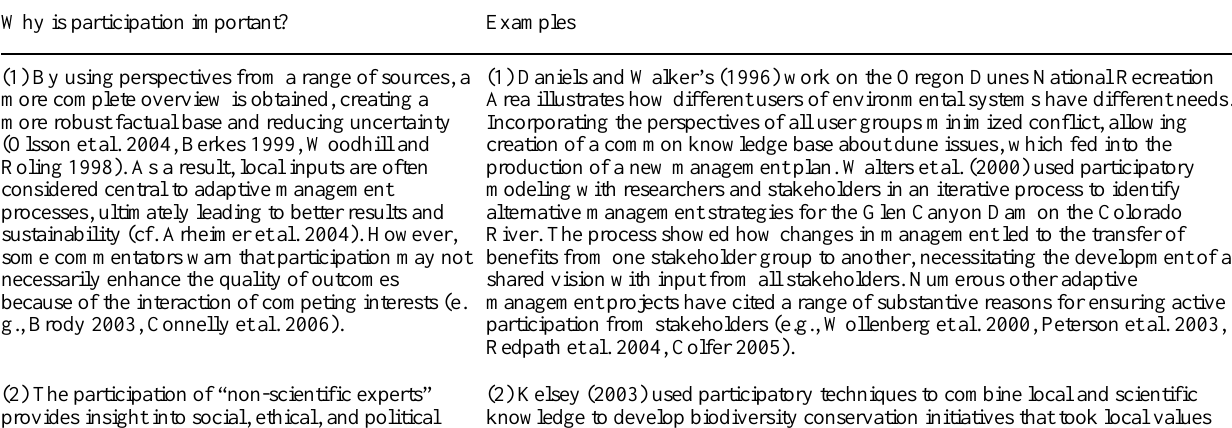
Table 1. Participation within adaptive management: why it is important Why is participation